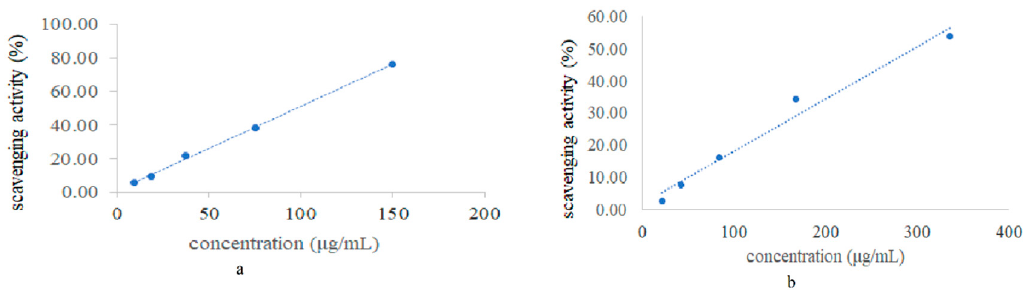
Figure 1. Scavenging activity of DPPH radical by BHT ( a ) and the essential oil of Curcuma wenyujin Y.H. Chen et C. Ling ( b ).